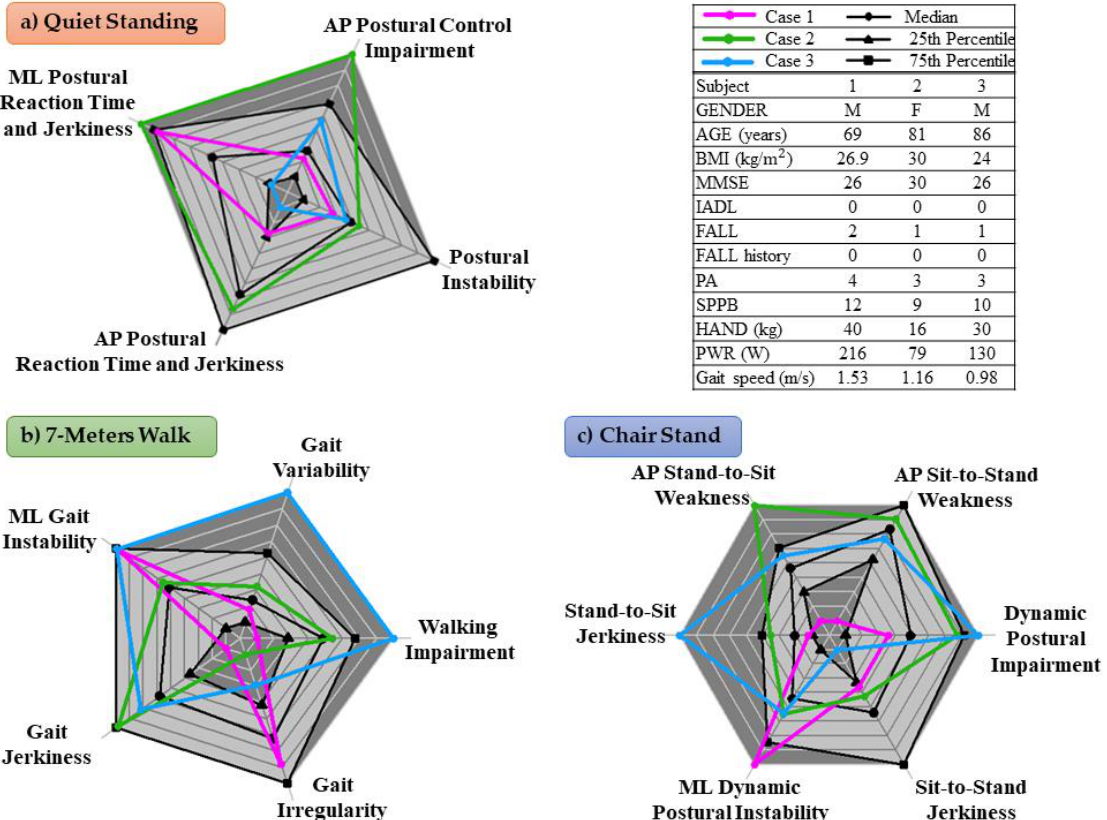
Figure 3. Three radar plots reporting the Quiet Stand ( a ), 7-meters Walk ( b ) and 5-times Chair Stand ( c ) domains of three different case studies. The black lines represent the median value, the 25th and 75th percentiles of the older adults’ factor scores. The dark gray area represents extreme values (very high, above the 75th percentile, or very low, below the 25th percentile). Favorable values of the scores, below the 75th percentile, reflected good performances in the domain.